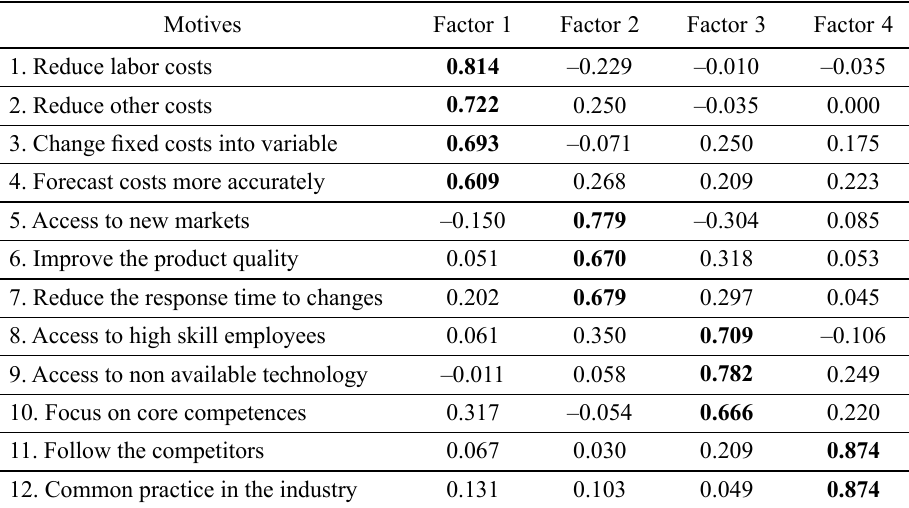
Table 4. Rotated component matrix